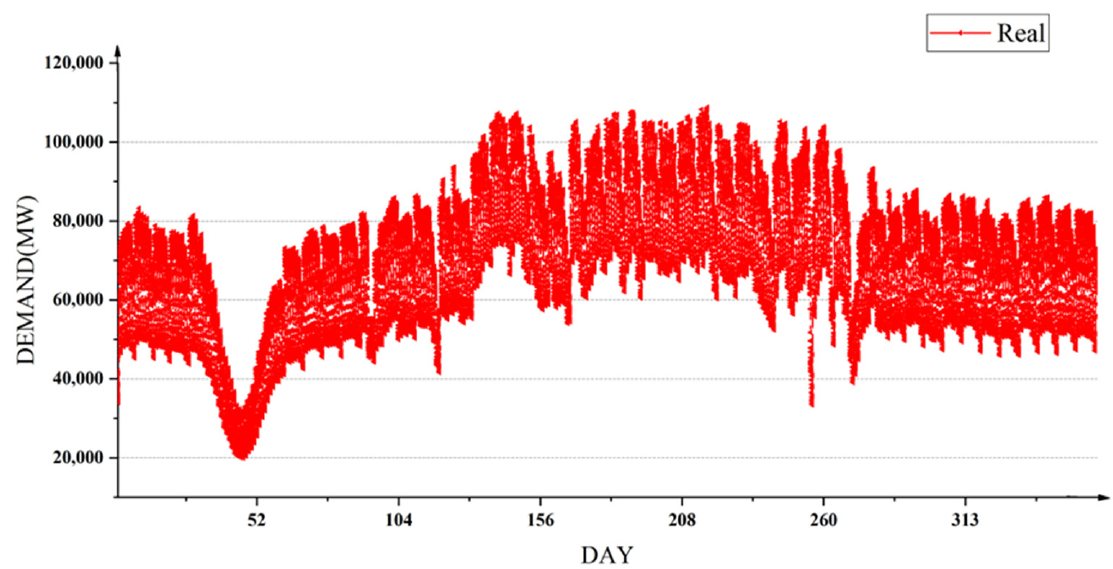
Figure 1. Original Electricity Consumption Data.